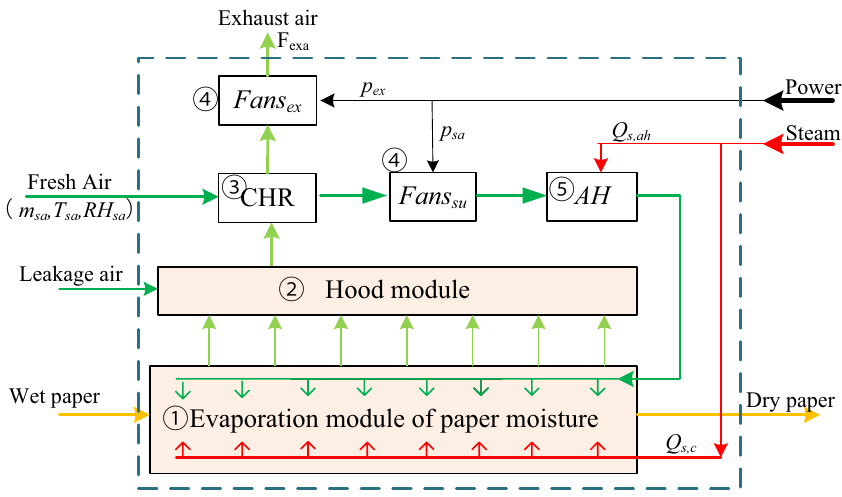
Fig. 2 Function modules of